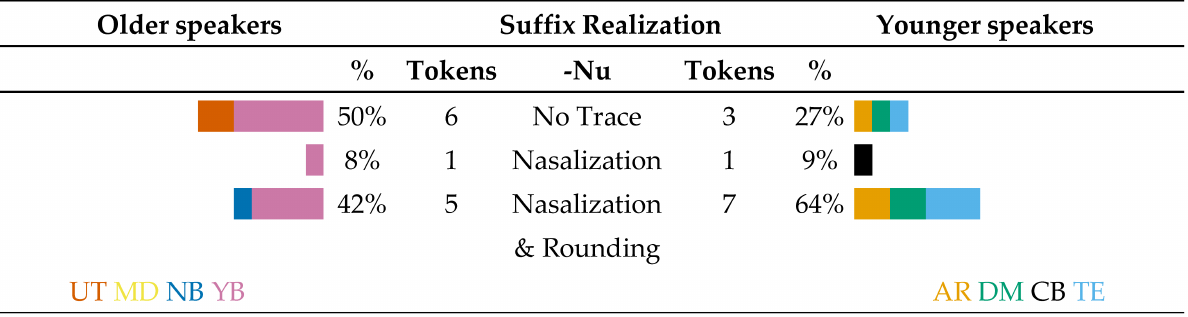
Figure 12. Residual features of elided suffixes on final vowel of verb stem. Colors refer to individual speakers, ordered youngest to oldest, left to